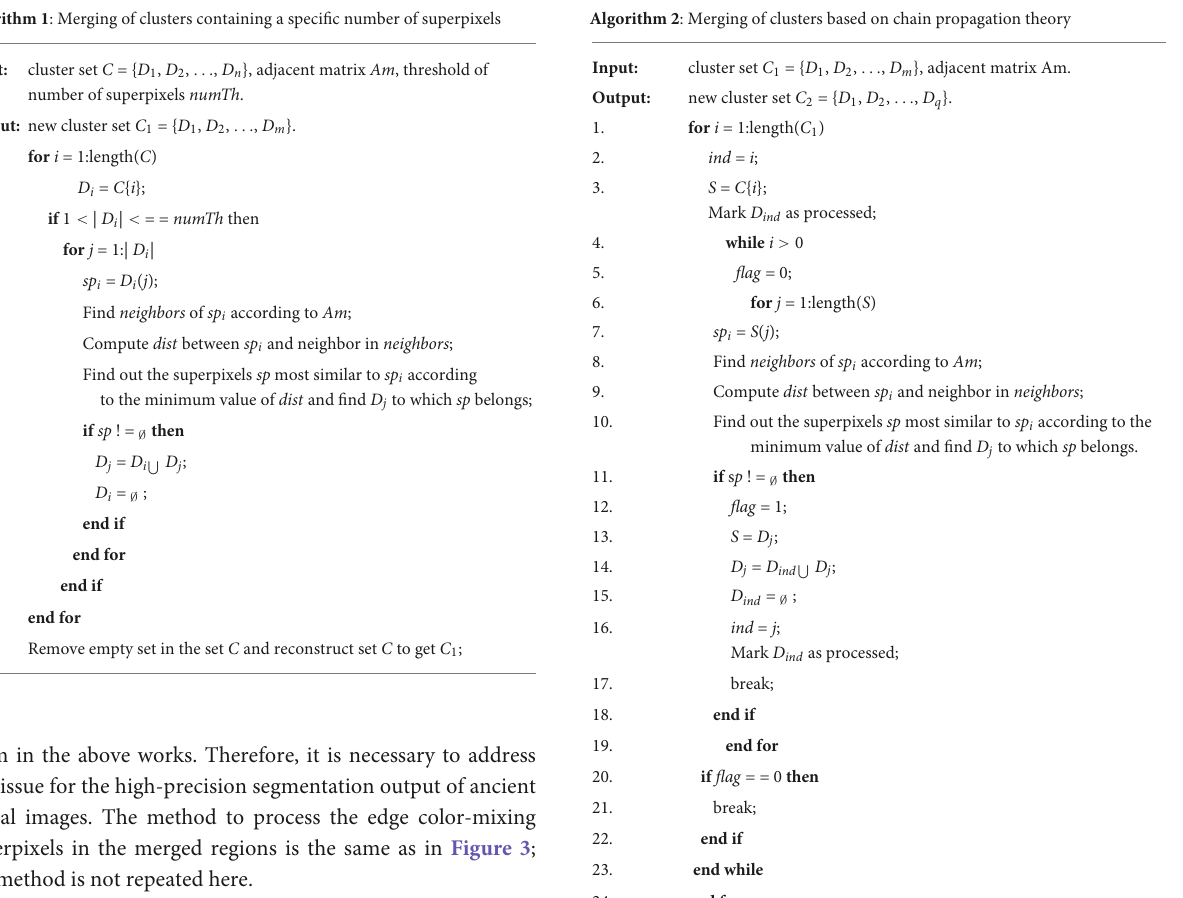
TABLE 2 Implementation of pseudocode in MATLAB language on merging the clusters based on chain propagation theory.